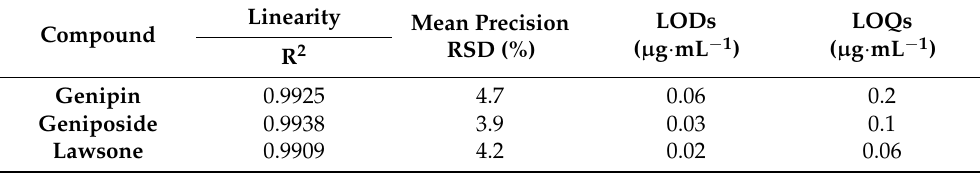
Table 2. UHPLC-QTOF performance. Linearity, precision, LODs and LOQs. Linearity Compound